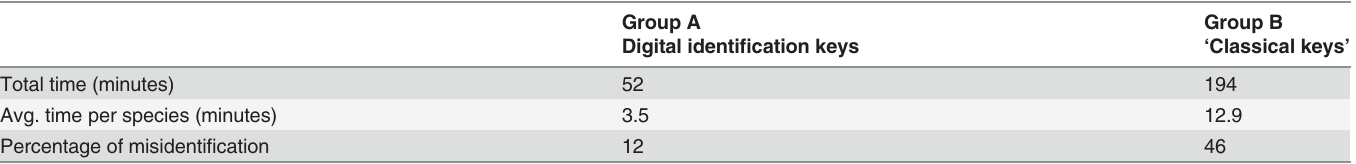
Table 1. Performance of a digital identification key produced by software FRIDA (group A) as compared with 'classical' paper-printed keys (group